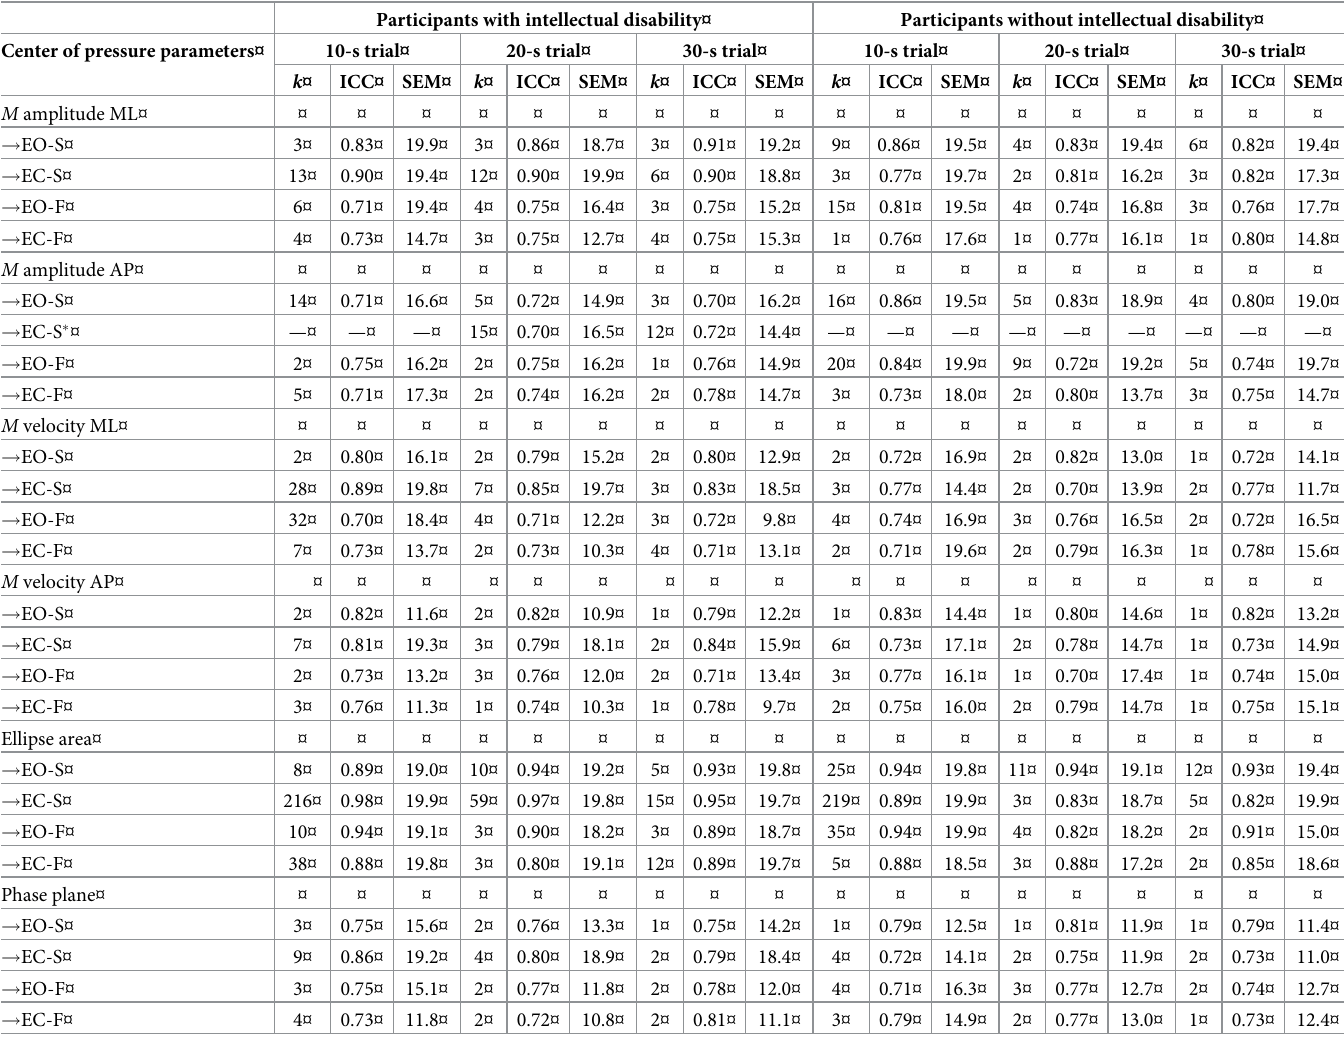
Table 2. Number of trials (k) that would yield an ICC 2,k � 0.70 and SEM% � 20 and corresponding ICC 2,k and SEM% for trial lengths of 10, 20, and 30